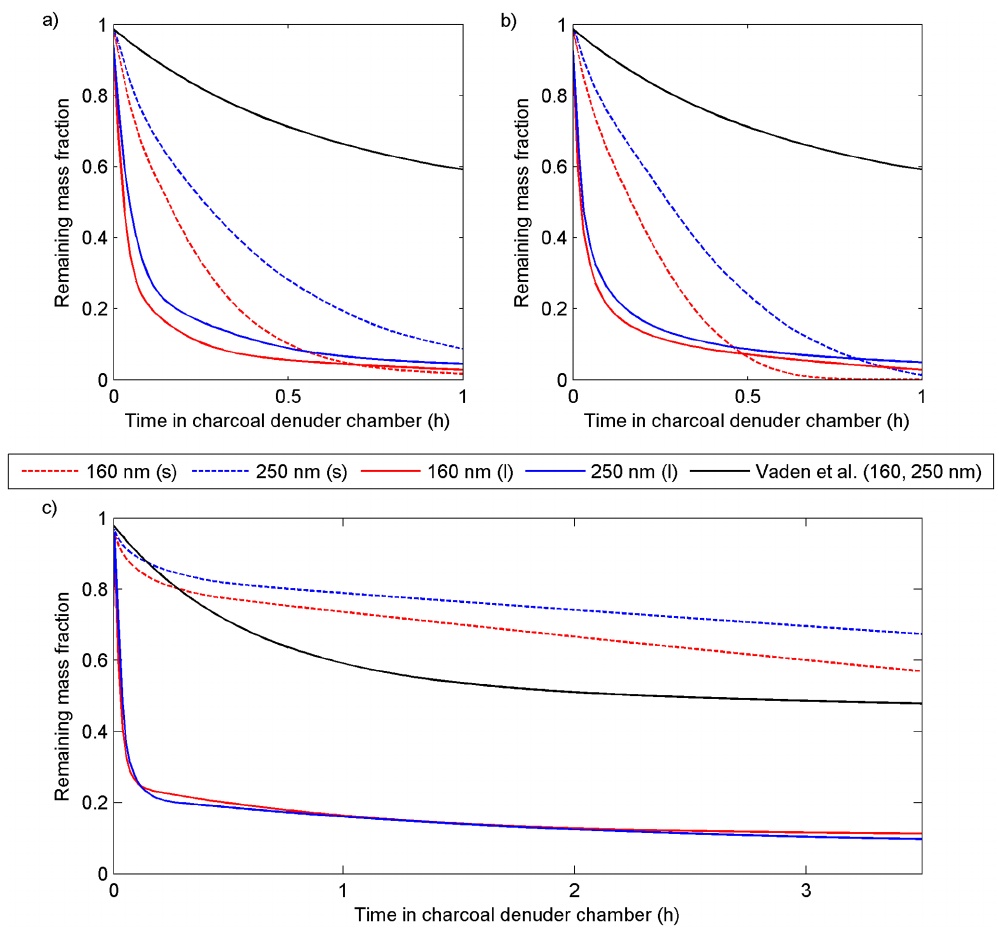
Figure 5. Modelled and measured (Vaden et al., 2011) evaporation rates of fresh α -pinene SOA. (a) Model results for SOA particles with volatility according to the VBS parameterization from Pathak et al. (2007). (b) Model results are from simulations with MCMv3.2 and vapour pressures estimated with SIMPOL. (c) Model results using vapour pressures estimated with the Nannoolal method. The evaporation loss rates are given for particles with a diameter of ∼ 160 and ∼ 250 nm, treated as liquid (l) or solid (s) (no diffusion between the particle layers). The reversible gas–wall partitioning of all α -pinene oxidation products onto the smog chamber Teflon walls was modelled with k ∗ g , w = 1 / 2000s − 1 and C w / (cid:0) M w γ w ,i (cid:1) = 100µmolm − 3